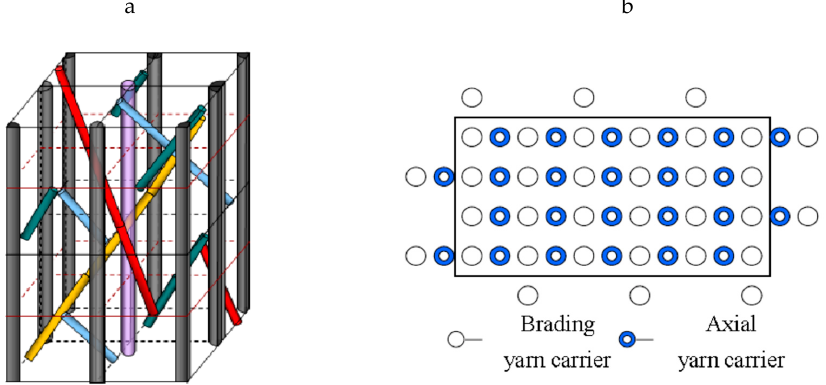
Figure 1. ( a ) The inner ideal structures of 3Dim–5Dir fabric. ( b ) Schematic illustration of carrier position on the machine